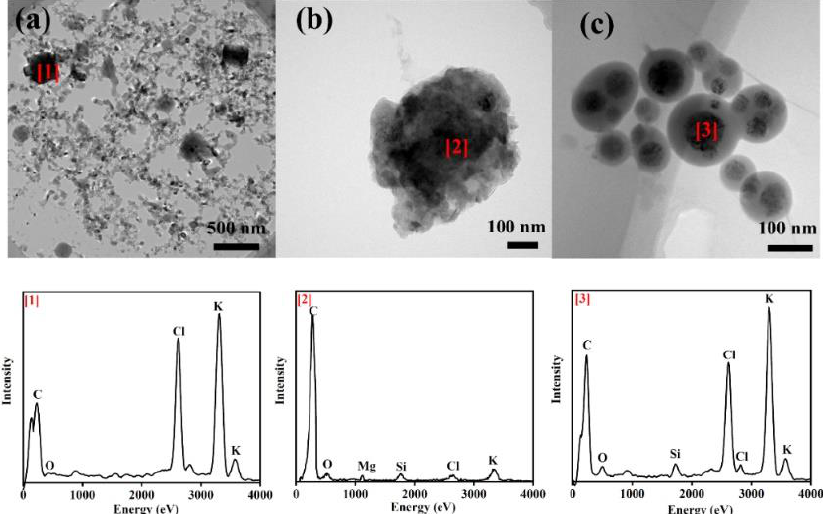
Figure 9. TEM images and EDS spectra of PM from the combustion of corn straw. ( a ) TEM images of multi-particle network morphology, ( b ) TEM images of soot morphology, ( c ) TEM images of individual particles. The corresponding EDS spectra are indicated by the number in square brack- ets.